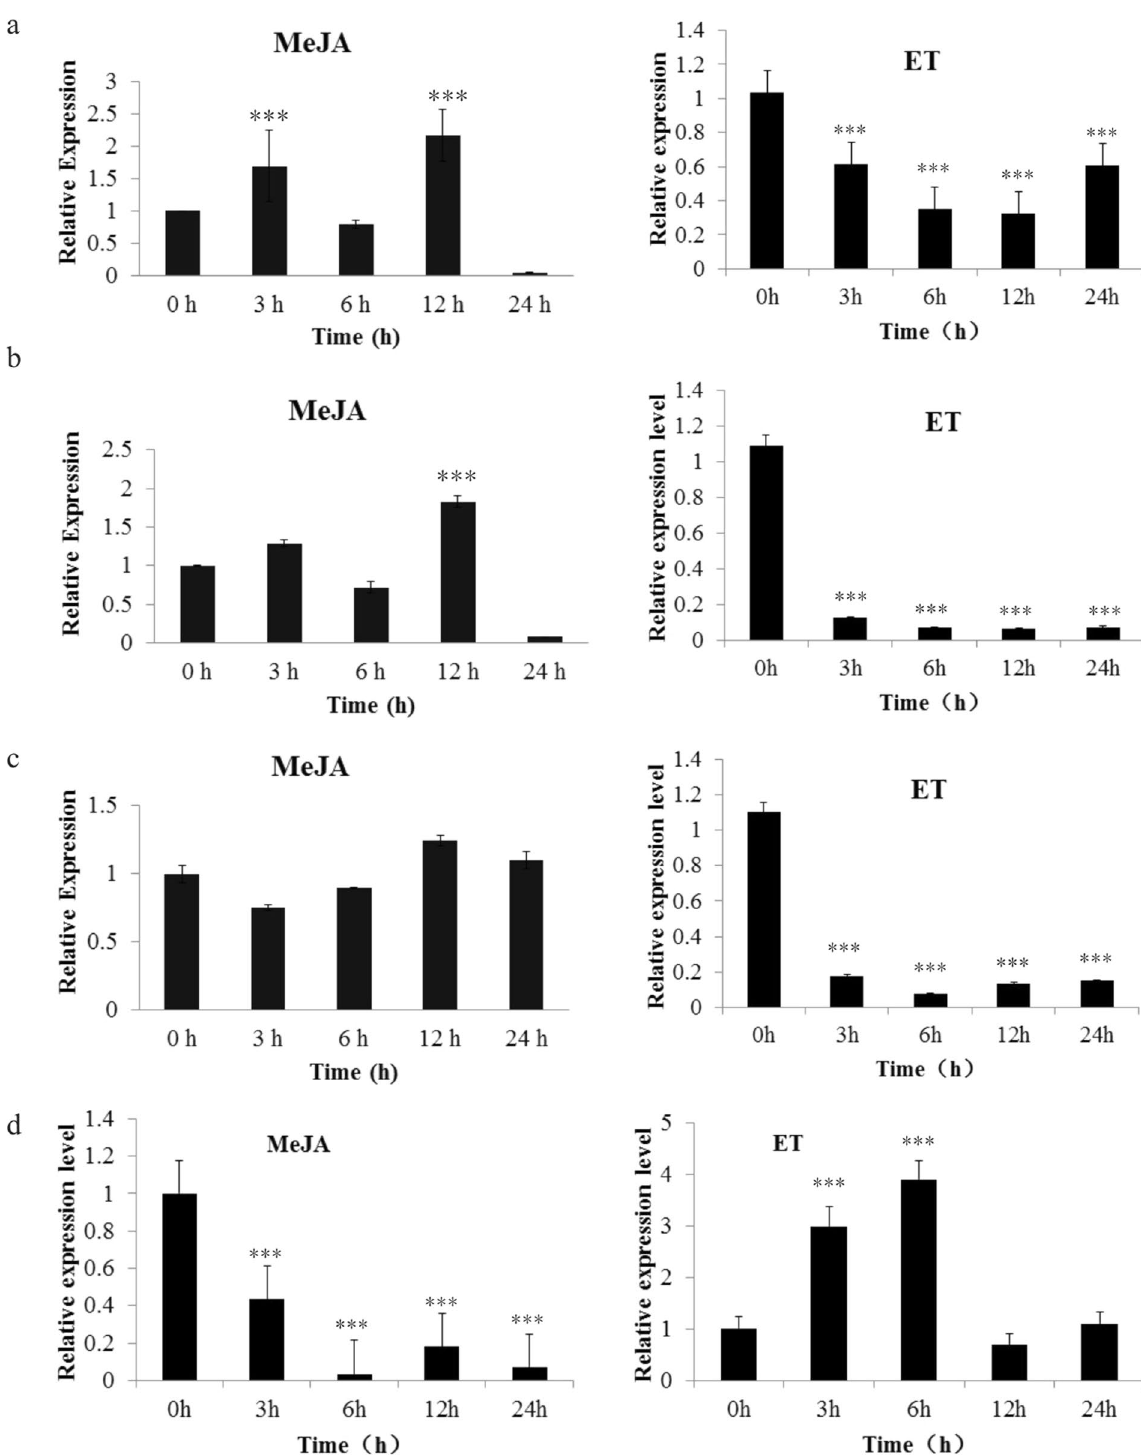
Figure 7. Different expression levels of HbMYC2/3/4 and HbPIP2;1 in the MeJA- and ET-treated leaves of rubber trees. Leaves of the epicormic shoots of Hevea brasiliensis were sprayed with 100 µ M methyl-JA or 100 µ M ethrel. Samples were collected at 0 h, 3 h, 6 h, 14 h and 24 h after treatment. Expression levels of the HbMYC2 ( a ), HbMYC3 ( b ), HbMYC4 ( c ) and HbPIP2;1 ( d ) genes were analysed by qRT-PCR. The values are the means ± SDs from the results of three replicates. Asterisks indicate significant differences compared with those of the 0 h control ( *** P < 0.005, Student’s